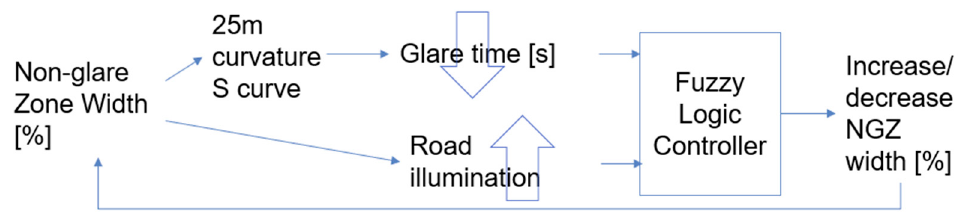
Figure 12. Schematic showing fuzzy logic controller block diagram.